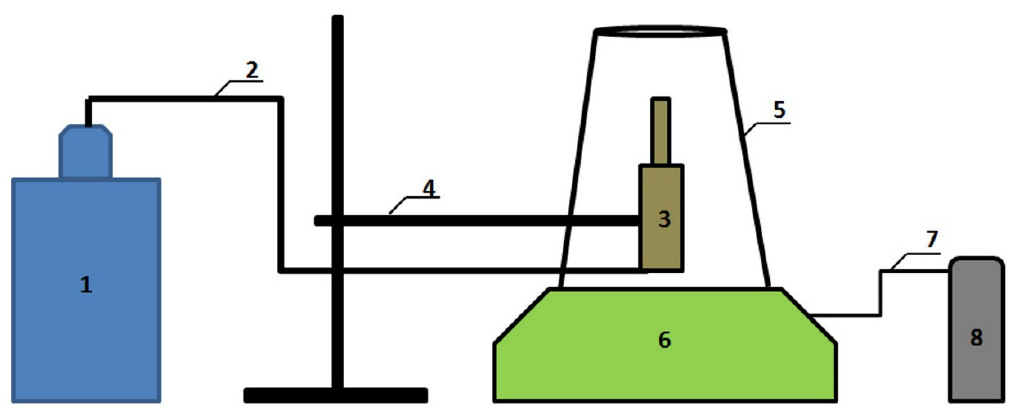
Figure 2. Test equipment scheme (legend: 1—gas bomb, 2—gas supply to the burner, 3—Bunsen burner, 4—burner holder, 5—specimen holder, 6—scales, 7—connection of the scales to the computer, 8—computer).